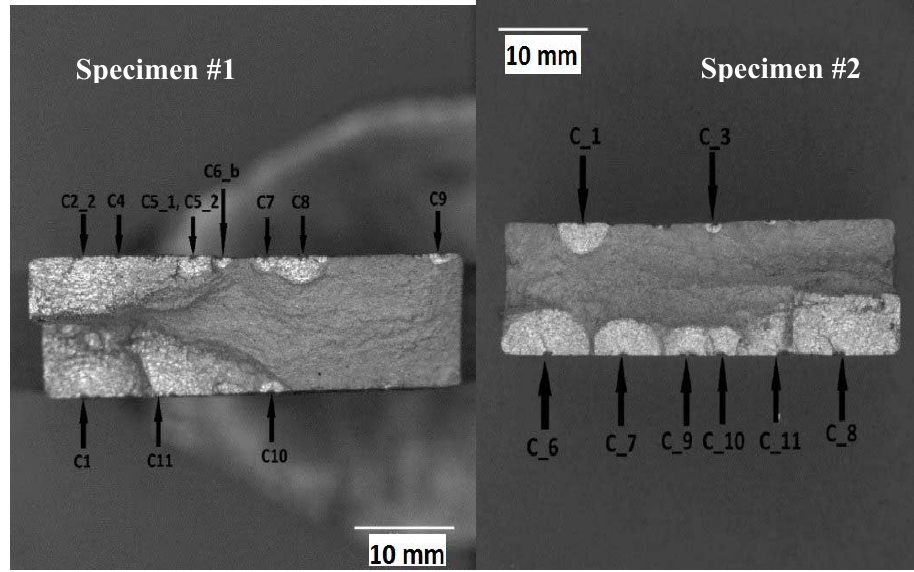
Figure 24. Fracture surface and schematic locations of cracks in Specimen #1 (left) and Specimen #2 (right).